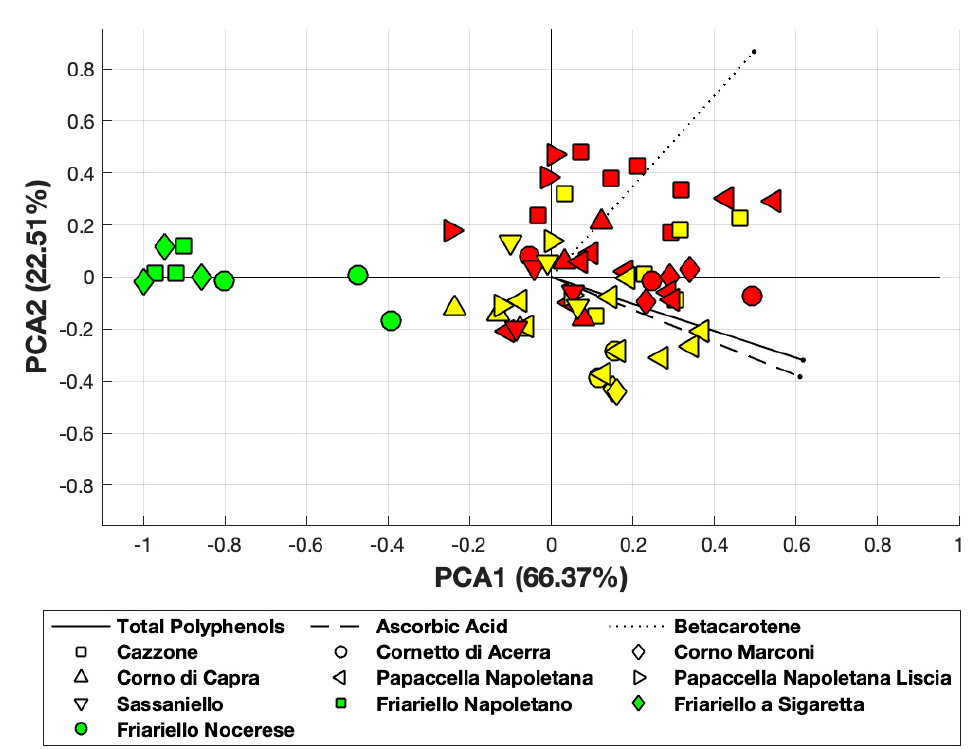
Figure 3. PCA obtained considering β -carotene, ascorbic and total polyphenols. Yellow and red-colored symbols indicate the yellow and red varieties, respectively.